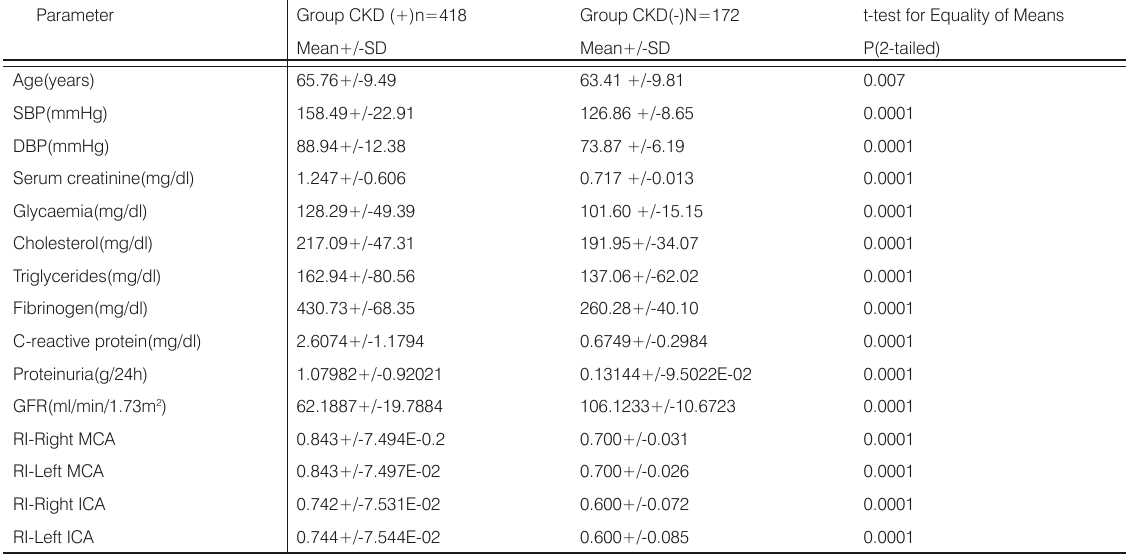
Table 1. Clinical, biological and ultrasound data in CKD (+) and CKD (-)